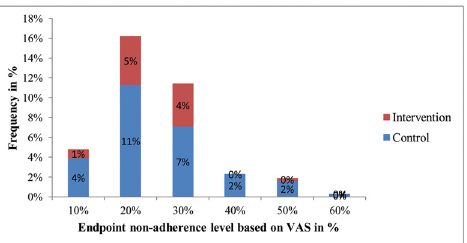
Fig 3. Endpoint non-adherence level distribution among control and intervention